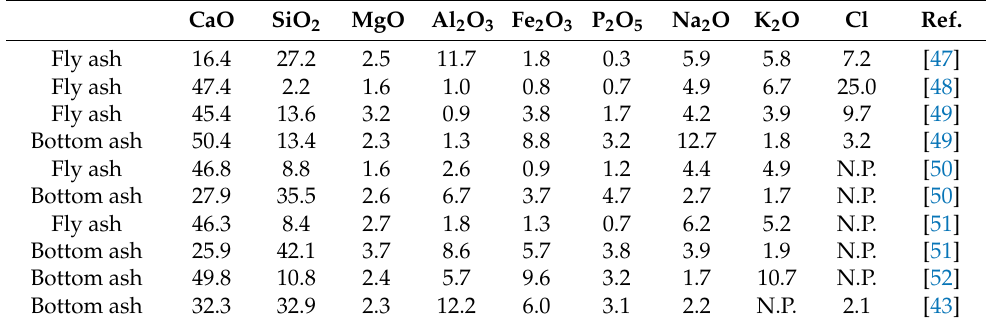
Table 1. Chemical compositions of MSWI bottom ash and fly ash from different sources (wt.%).